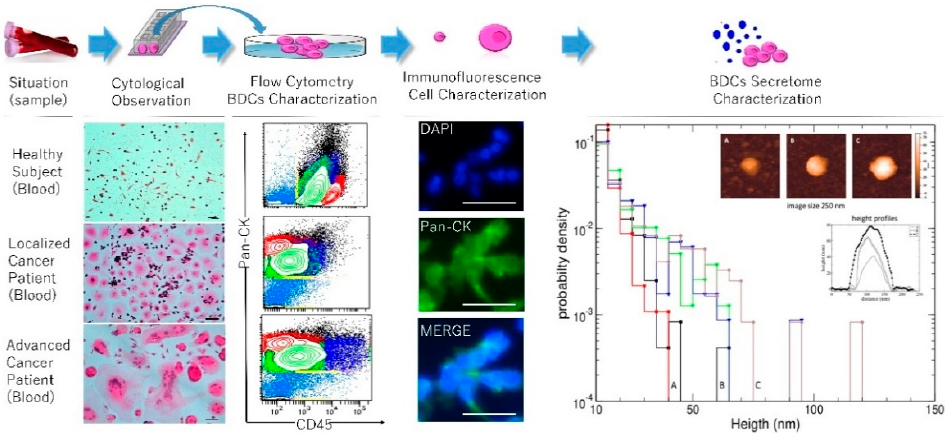
Figure 1. Blood-derived cultures and secretome characterization. The top panel describes an experimental workflow starting from the blood sampling up to the secretome characterization. H&E stained cytological preparations, were prepared from the blood-derived cell cultures (BDCs) derived from samples collected by healthy volunteers and cancer patients in different stages of two reported cases of breast cancer. The cultured cell population was analyzed for the expression of CD45 to evaluate the in vitro hematological (CD45 + ) and non-hematological (CD45 − ; Pan-CK + ) compartment of the cells isolated and expanded. Immunofluorescence for the expression of Pan-CK in an advanced case of breast cancer was reported. The secretome complexity pattern was analyzed with AFM. Secretive vesicles (ranging from 50 to 250 nm in size) in healthy, thyroiditis, and in thyroid carcinoma blood-derived cultures secretome. The distribution density of particles height is plotted with a bin width of 5 nm. The insets show representative images of particles of each population, alongside with height profiles traced through the particles. Scale bars in cytological and immunofluorescence panels correspond to 50 µm.